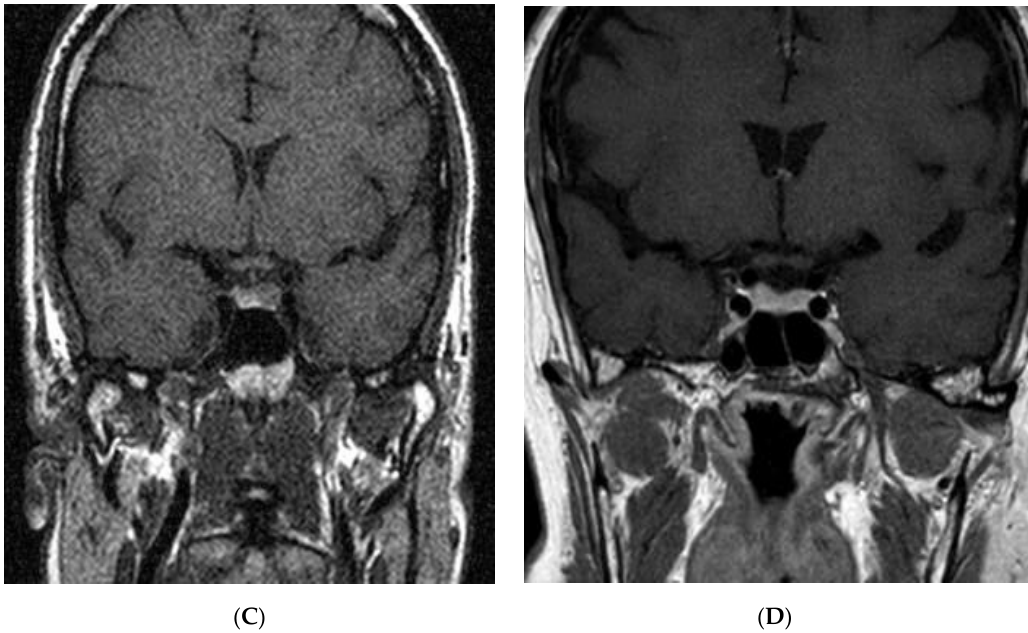
Figure 1. Magnetic resonance imaging (MRI) results in AIP mutation-positive members of the familial isolated pituitary adenoma (FIPA) kindred. Panel ( A ) shows the last follow-up coronal T1 weighted MRI decades after neurosurgery and external beam radiotherapy for the treatment of acromegaly. The image reveals a linear residue of pituitary tissue on the sellar floor and retraction of the optic chiasma. Panel ( B ) is a coronal T1 weighted MRI that demonstrates a cystic lesion measuring 19 × 14 × 7 mm in individual III-1 >50 years after surgery and radiotherapy for young onset acromegaly. Panel ( C ) is a coronal T1 weighted MRI that illustrates a recurrent pituitary adenoma measuring 10 × 9 × 8 mm adenoma in individual III-7, who was diagnosed with a prolactinoma 35 years previously. The recurrent tumor was associated with prolactin hypersecretion, mild insulin-like growth factor-1 (IGF-1) elevation and acromegalic features, leading to a diagnosis of a mixed tumor that responded to cabergoline. Panel ( D ) shows a coronal T1 weighted image of the normal pituitary in individual III-4, an aryl hydrocarbon receptor interacting protein ( AIP ) gene mutation carrier who is the mother of the index patient.